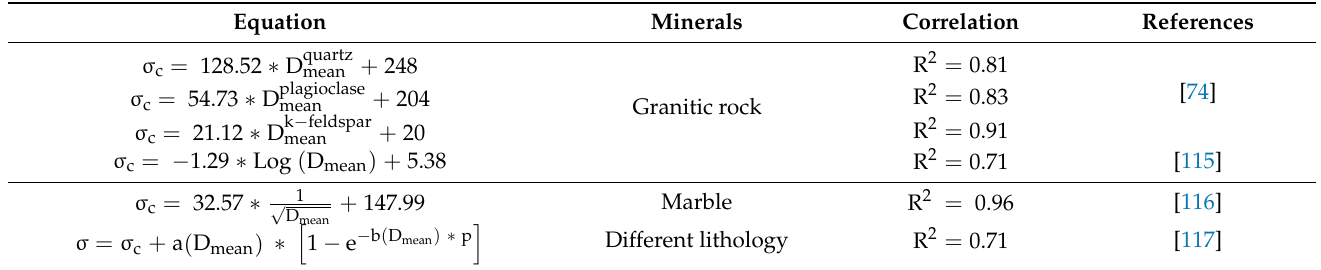
Table 14. Regression equations between geomechanical properties and mean grain size (adapted from [60]). ( σ c is unconfined compressive strength in MPa; σ is compressive strength in MPa; D mean is the mean grain size of all constitutive minerals in mm; D quartz mean , D plagioclase mean , and D k are, respectively, the mean grain sizes of quartz, plagioclase, and K-feldspar minerals in mm; P is the confining pressure in MPa; a and b are empirically determined constants that depend on mean grain